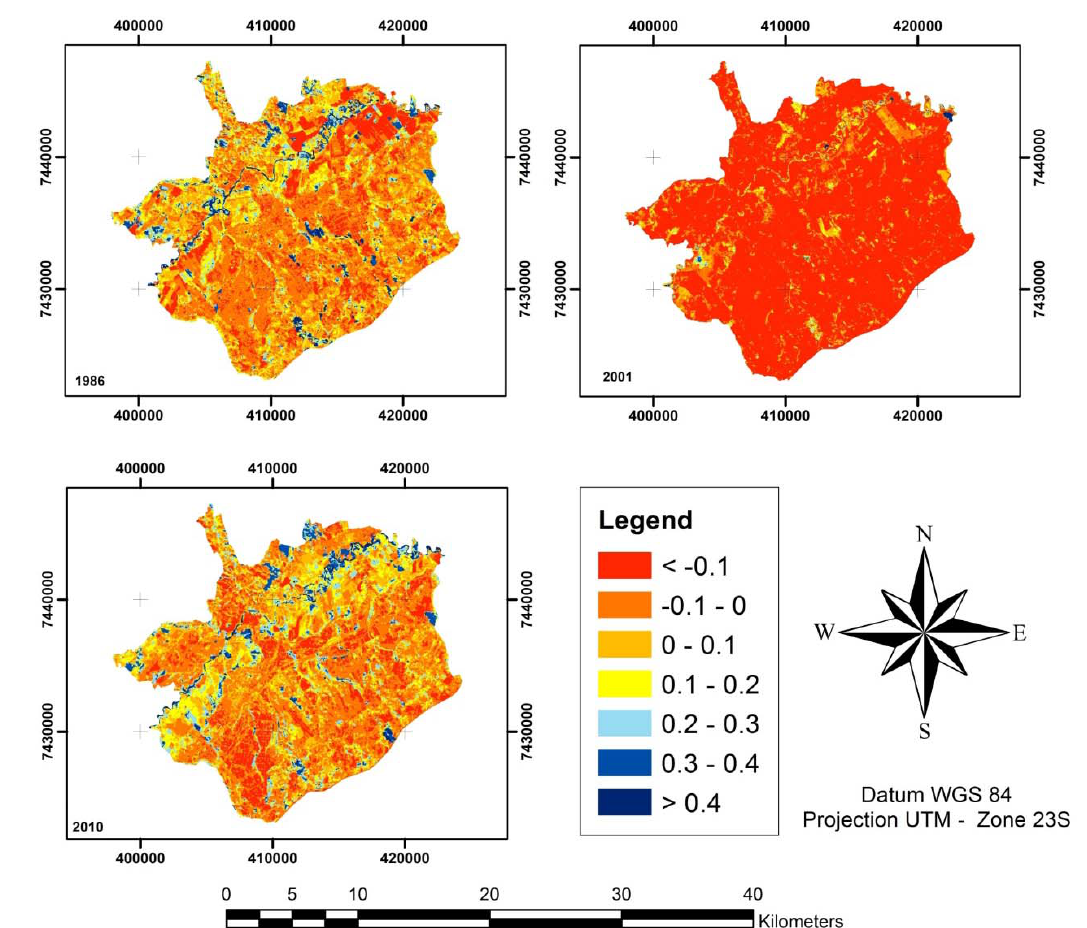
Figure 8. NDWI calculated from the image of TM/Landsat 5 for 1986, 2001, and